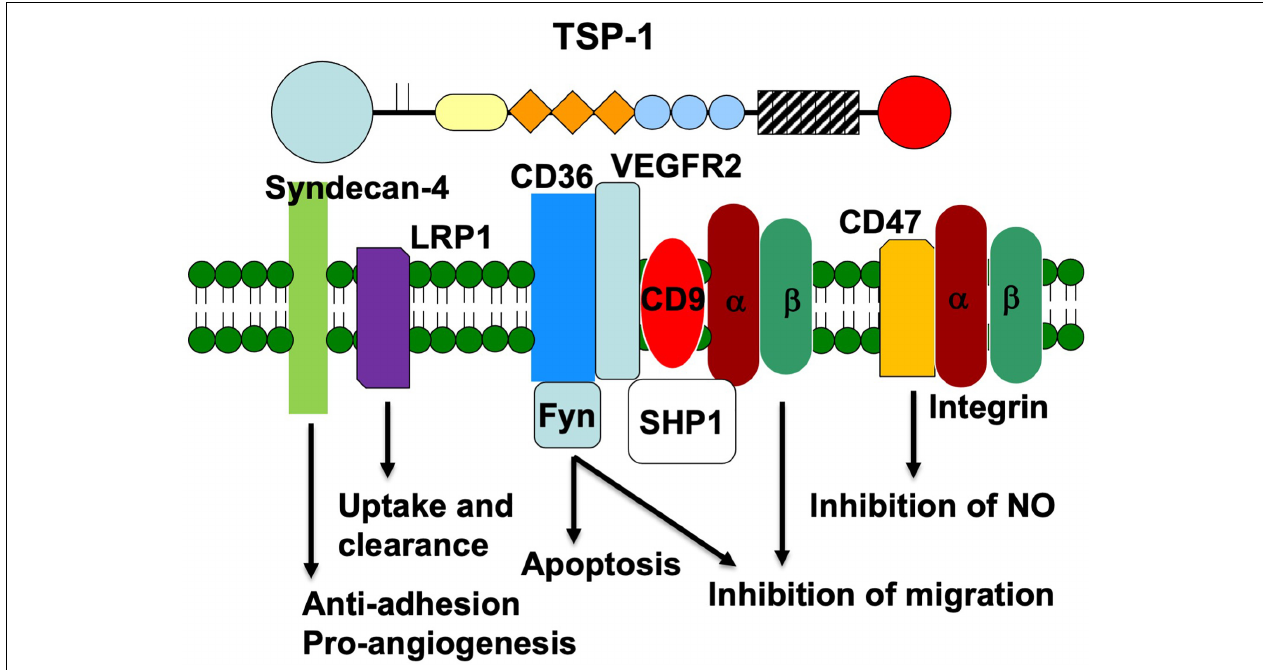
FIGURE 1 | Schematic representation of the endothelial cell receptors that interact with the various domains of TSP-1. The receptors are placed under the domain with which they interact. The signaling proteins that associate with each receptor and the signal that is transduced are also indicated.